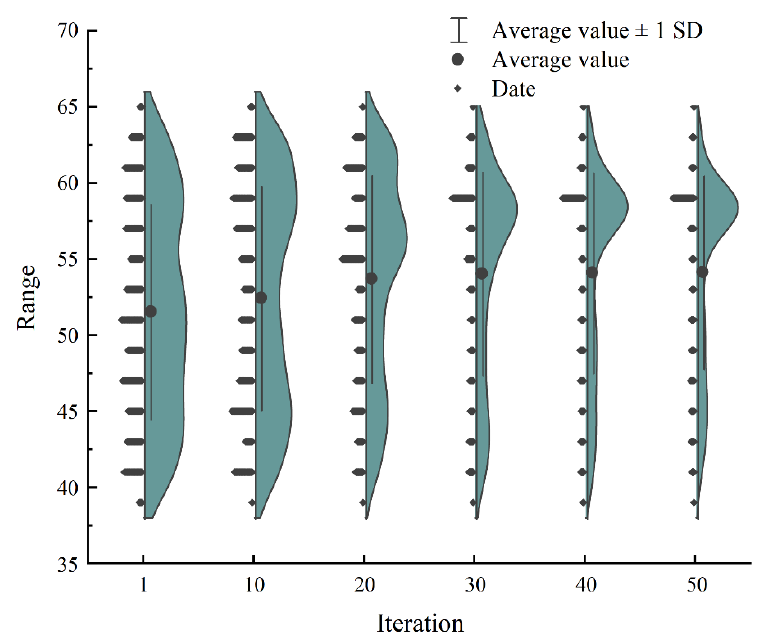
Figure 7. Population distribution of hydrant discharge during iteration.